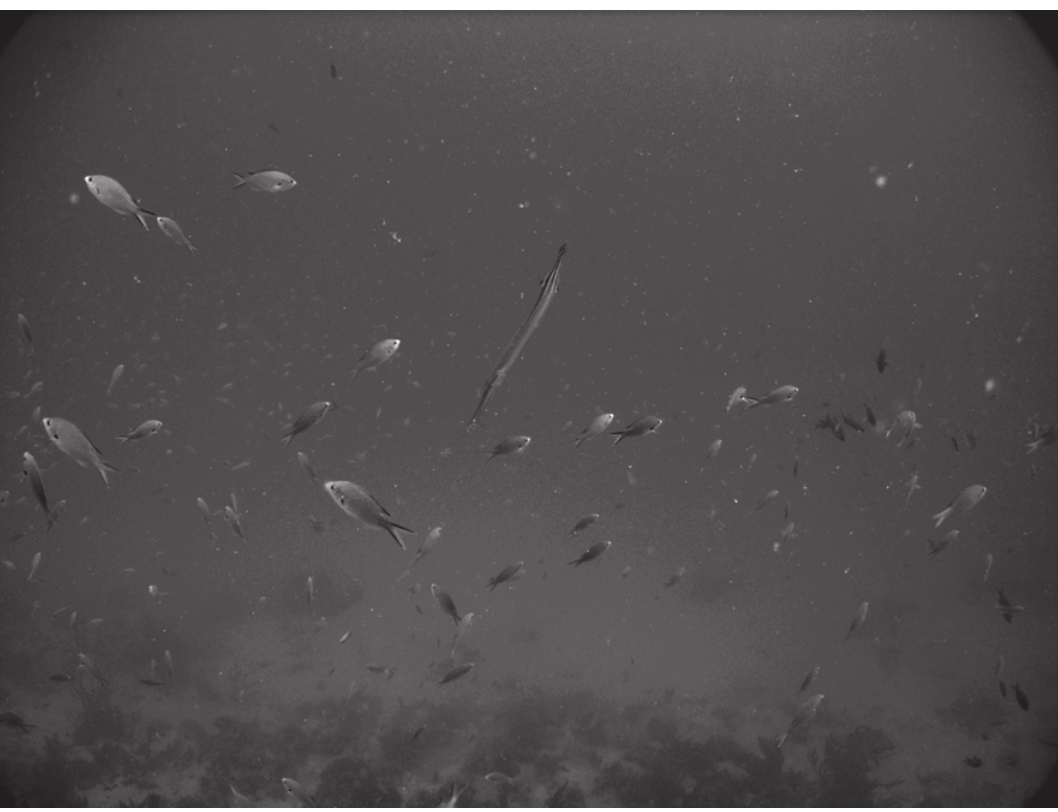
Fig. 2. A trumpetfish transiting diagonally through a feeding aggregation of brown chromis. Trumpetfish made small corrections in trajectory to encounter potential